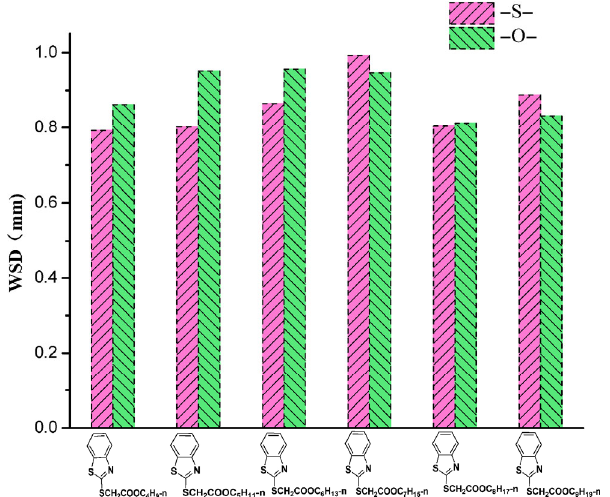
Fig. 22 The wear scar width of each steel ball when lubricating with 2-benzothiazole-S-carboxylic acid esters and their isosteres in TMPTO.